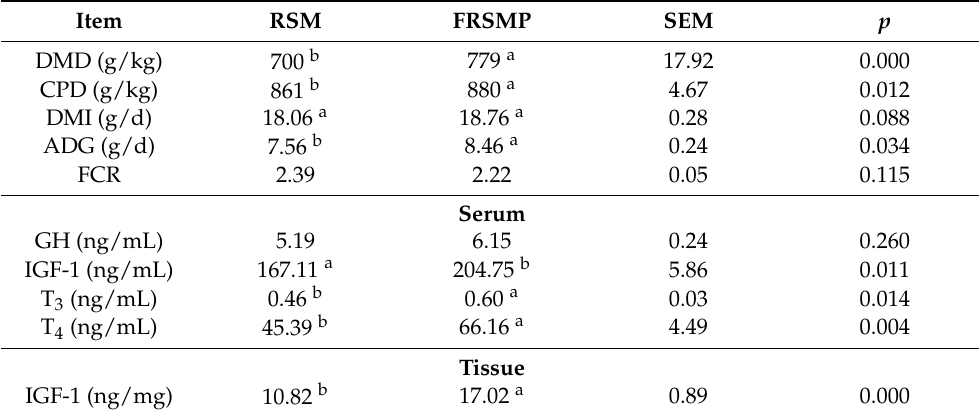
Table 4. Effects of the RSM before and after fermentation on nutrient digestibility in vitro and growth-promoting activities of weaned rats in vivo.